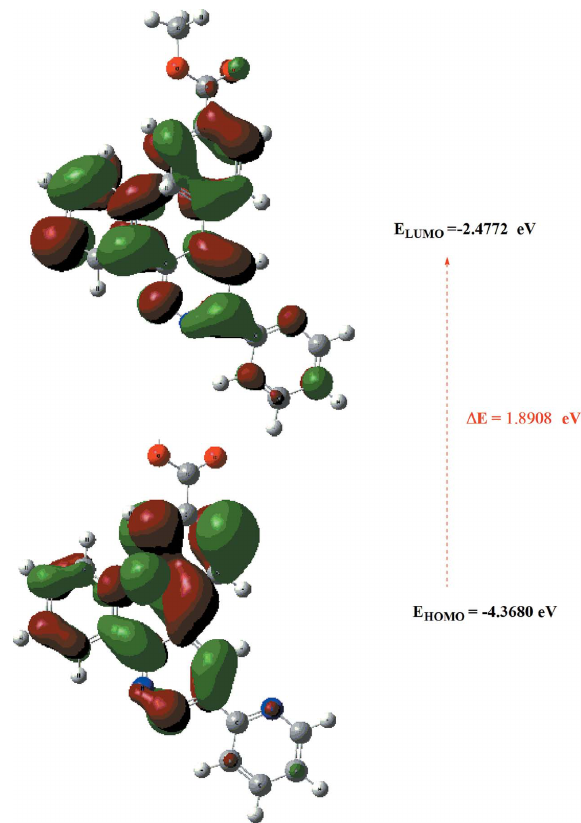
Figure 8 The energy band gap of the title compound.